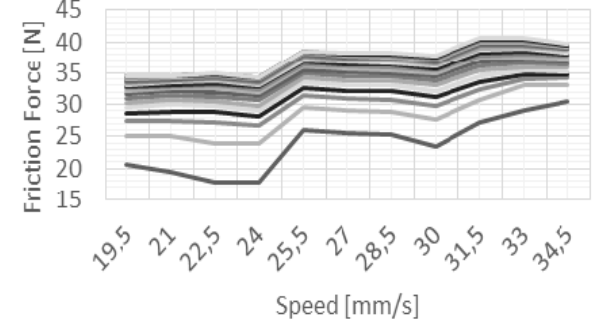
Fig. 9. Changes of friction forces during 15-seconds